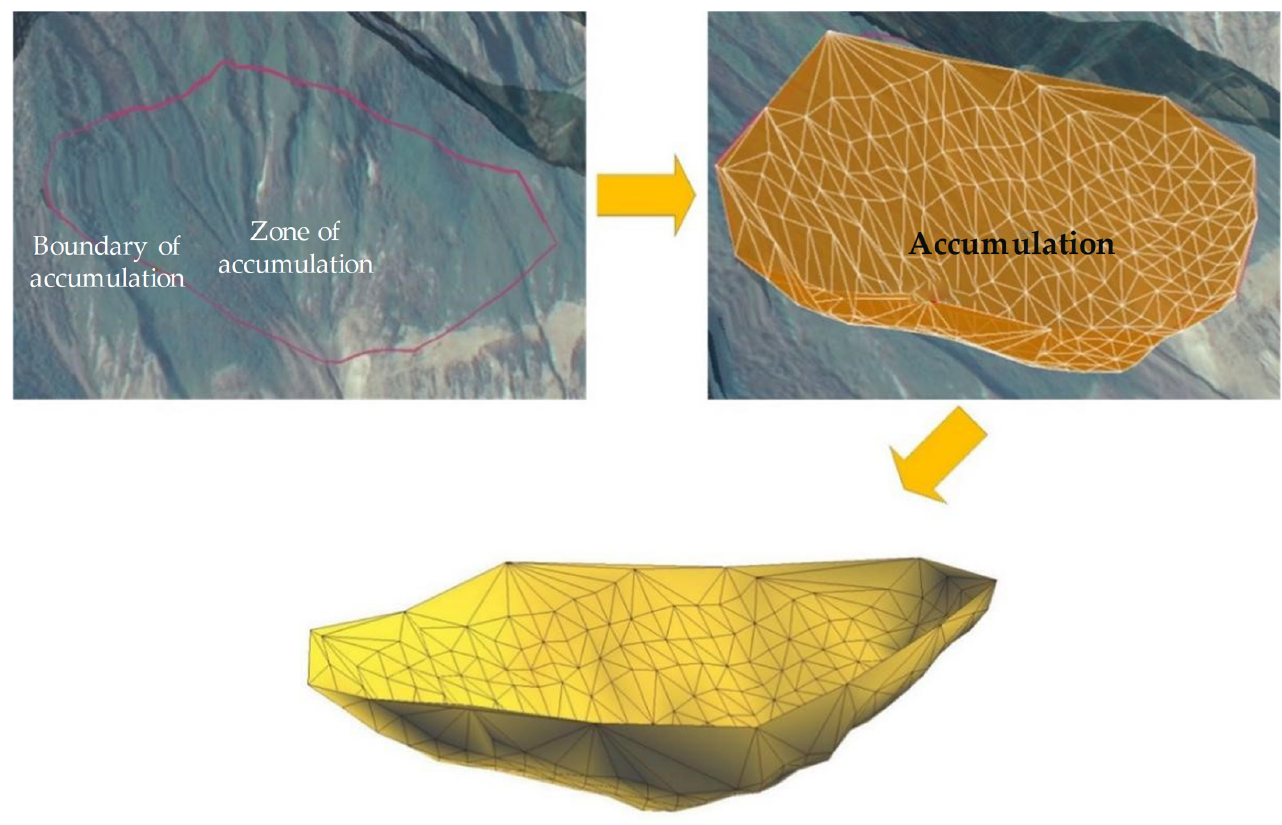
Figure 12. Bottom surface estimation of accumulation